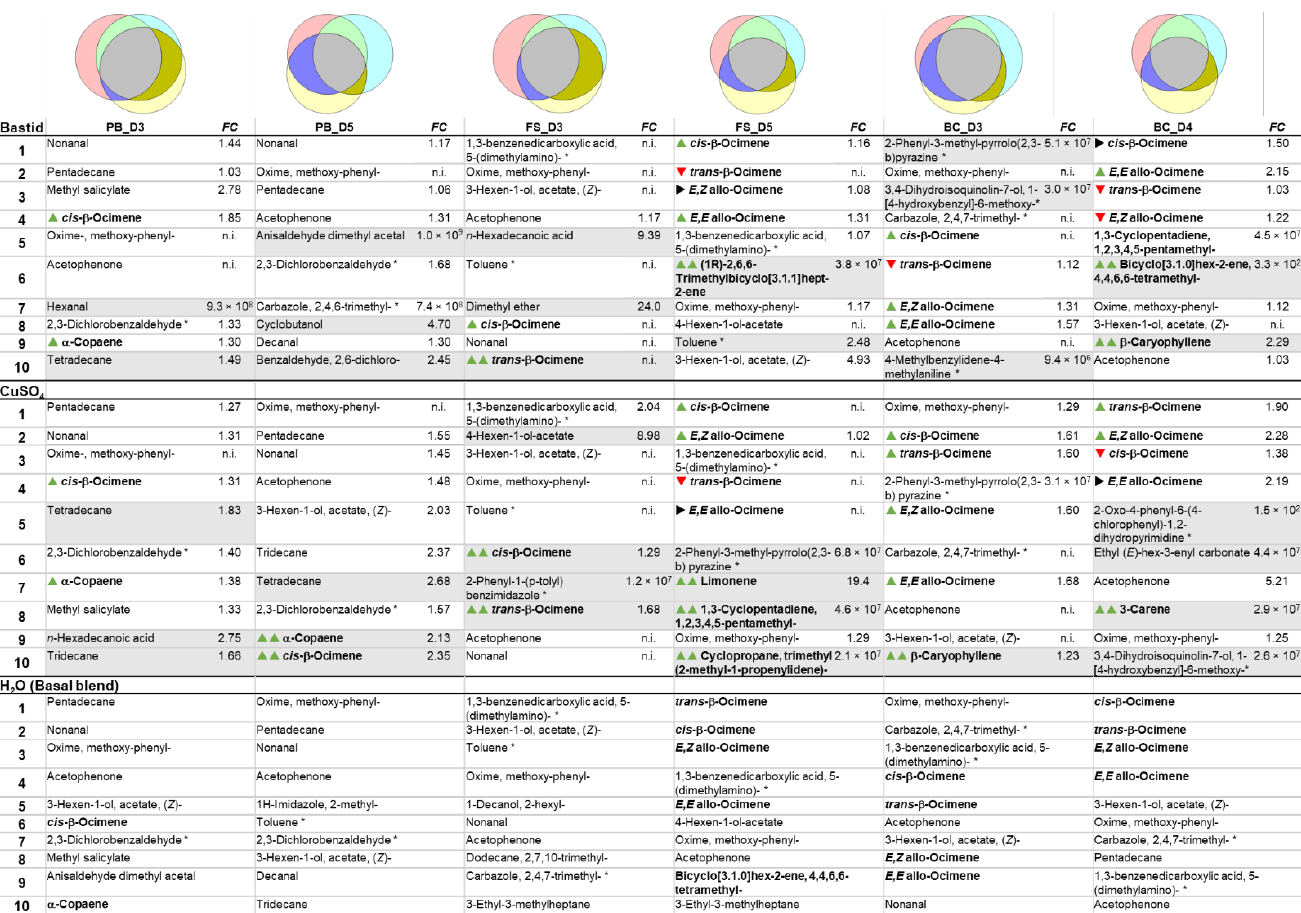
Table 5. TOP10 VOCs detected in Bordeaux vineyard. Venn diagrams of the distribution of the 10 most abundant VOCs detected in Bordeaux vineyard for each condition and each time point (H 2 O, yellow; Bastid ® , pink; CuSO 4 , light blue). In the tables, compounds are ranked from 1 to 10, according to their average intensities measured in Bastid ® -(top table), CuSO 4 -(middle table) and H 2 O-(bottom table) treated grapevines. The fold change (FC) relative to the H 2 O control is indicated for each induced VOC. Terpenoids are in bold type. Arrows, variation of terpenoid ranking relative to H 2 O ( up; stable; down ranking). Grey coloured lines, elicitor-induced VOCs absent in the water control; induced terpenoids. Phenological stages of grapevine: PB, pre-blossom; F, fruit-set; BC, bunch-closure. Time points: three- and five-days post treatment (D3 and D5). n.i.: not induced; *: putative contaminant.